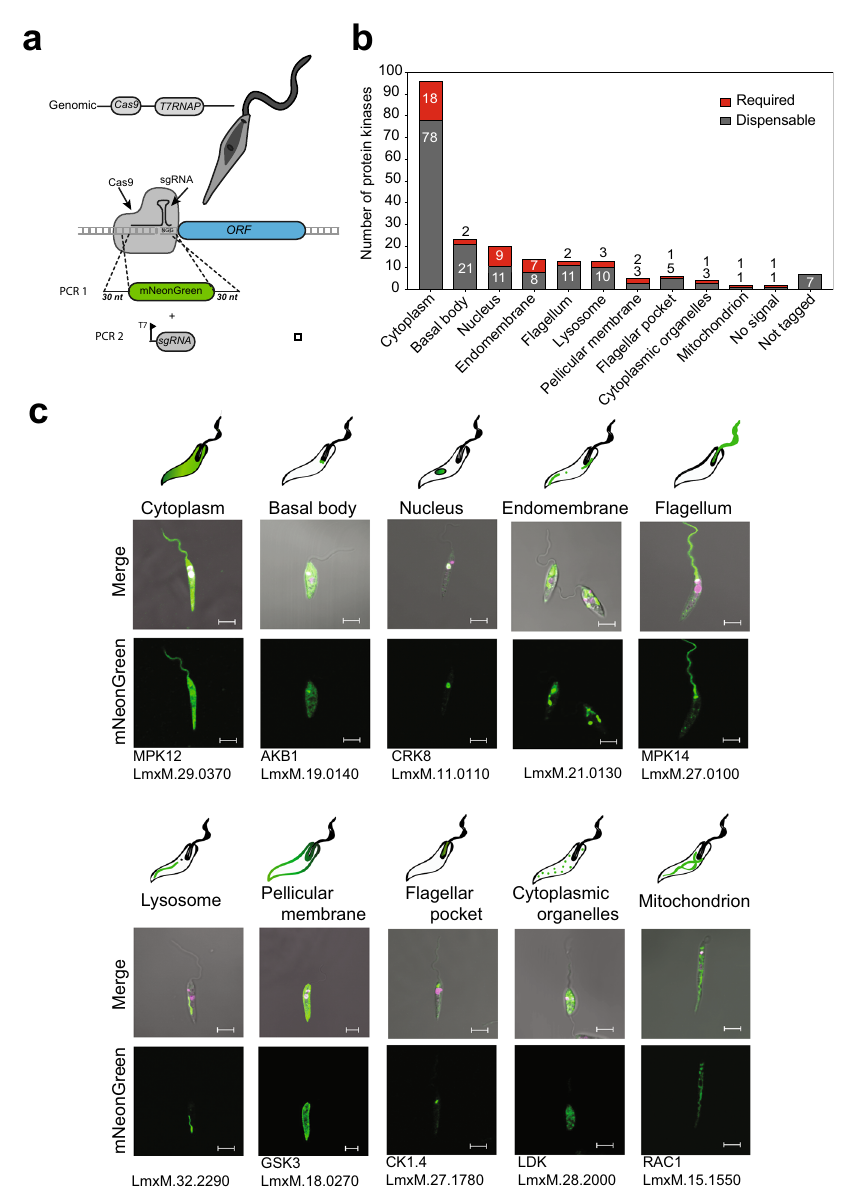
Fig. 3 Endogenous tagging of L. mexicana protein kinases. a Schematic representation of a process for N-terminal tagging. Transfection of the sgRNA (PCR1) directs the double-stranded break immediately upstream of the target CDS and the repair template (PCR2) contains 30 nt at 5 ′ and 3 ′ of the fragment for homologous recombination on the target locus to insert the fl uorescent tag and an antibiotic-resistance gene. b Bar graph representing the localisation of dispensable and required protein kinases for each organelle. c Pictorial illustration of the 10 localisation groups. An exemplar live-cell image of protein kinases tagged with mNeonGreen for each localisation. Procyclic promastigotes were incubated with Hoechst 33342 for DNA labelling (pink). Scale bar: 5 μ contains 12 trajectories for mutants that exhibited an increased signi fi cant increase in representation during metacyclic enrich- representation during the mouse infection time points compared ment followed by a sharp decrease during footpad infection time to others, indicating a relative gain of fi tness in the population. points. Cluster 6 (grey) contains protein kinase mutants with Cluster 2 (red) contains trajectories with an average representa- trajectories which show a general loss of representation over time tion throughout promastigote stages and small increase between with a slight recovery during metacyclic enrichment. Each of the the metacyclic enrichment and three-week footpad infection individual kinase trajectory examples (Fig. 4b and Supplementary stage. Cluster 3 (sky blue) contains the largest group of protein Data 5) are found in separate clusters and provide an example of kinase mutants with fairly fl at trajectories, decreasing slightly on the data for the axenic amastigotes and macrophage infections. average from the point of metacyclic enrichment. Cluster 4 The percentage barcode representations for each of the mutants (purple) contains protein kinase mutants that on average exhibit are also shown in a heat map format for each of the clusters, fairly fl at trajectories throughout the promastigote stages, depicting the trends for individual mutants. PCA analysis demonstrating average growth, with a decrease in fi tness upon supports the relationship between the different clusters (Fig. 4d footpad infection. Cluster 5 (blue) contains mutants that show a and Supplementary Data 5).